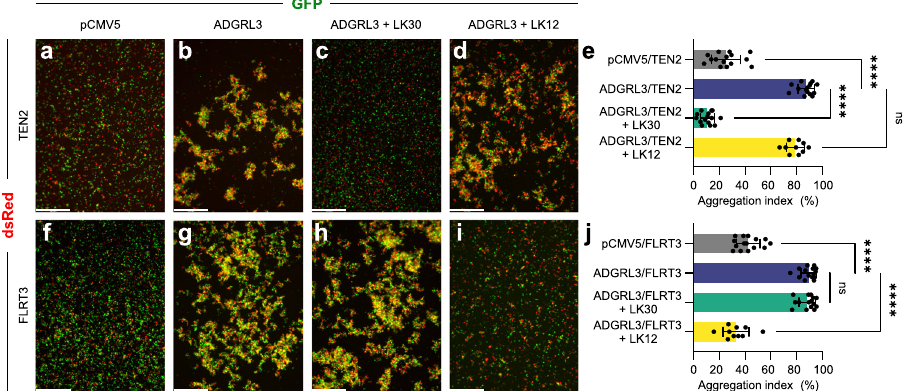
Fig. 5 | sABs speci fi cally inhibit cell-cell adhesion mediated by ADGRL3-ligand interactions. a-d and f-i Cell-aggregation experiments show full-length ADGRL3 expressed on HEK293T cells interact with full-length TEN2 expressed on another population of HEK293T cells in a trans-cellular manner ( a , b ) Similarly, ADGRL3 interacts with full-length FLRT3 expressed on HEK293T cells in a trans-cellular manner as well ( f , g ). Addition of 5 μ M sAB LK30 breaks the ADGRL3/TEN2 inter- action and abolishes cell adhesion ( c ), but does not interfere with ADGRL3/FLRT3 interaction ( h ). In contrast, 5 μ M of sAB LK12 breaks ADGRL3 interaction with